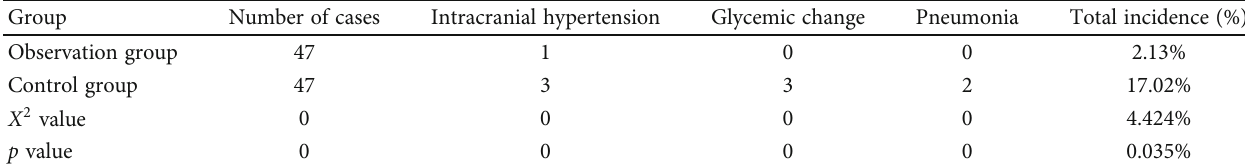
Table 1: Comparison of the incidence of complications between the two groups ( n ).